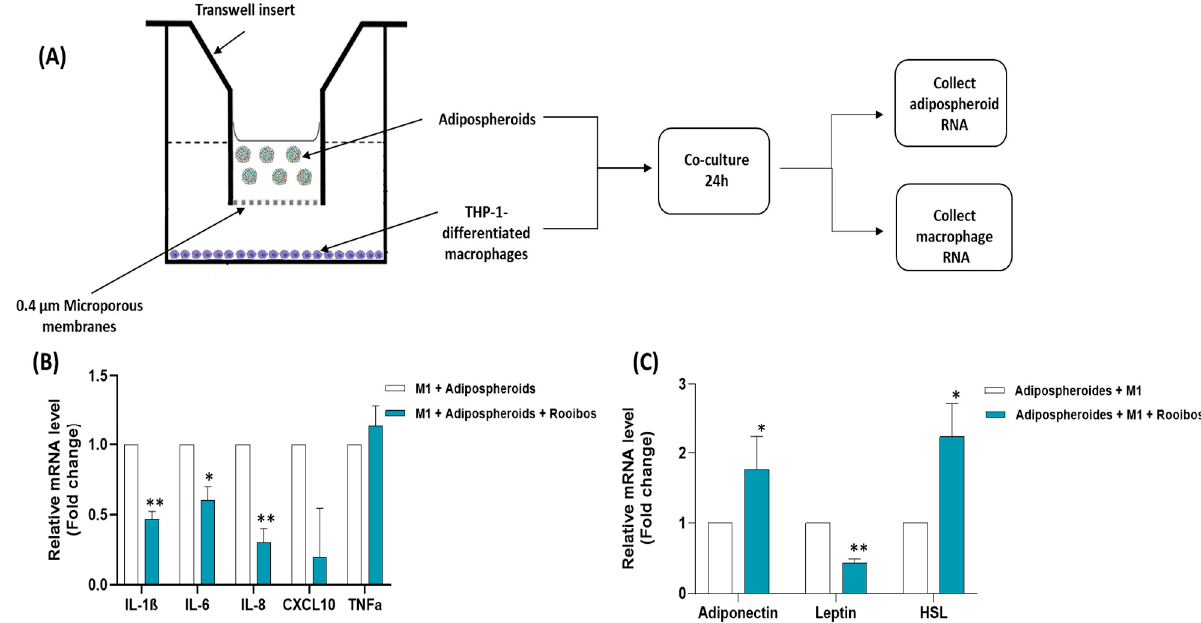
Figure 7. Effect of Rooibos on Adipocyte/Macrophage Interaction. ( A ) Diagram showing co-culture system where THP-1 were cultured in the lower chamber and adipospheroids were added after differentiation on a transwell insert; ( B ) the mRNA expression of IL- 6 , TNF α , IL-1 β , IL-8 and CXCL10 was measured by qRT-PCR in M1 cells after 24 h of co-culture; ( C ) the mRNA expression of adiponectin , leptin and HSL was measured by qRT-PCR in the adipospheroids after 24 h of co-culture. Total RNA isolated from untreated M1 macrophages or adipospheroids was used as the control. Data shown are the relative mRNA expression of the mentioned genes normalized to β -actin , * where p ≤ 0.05 and ** where p ≤ 0.01 and n = 3.